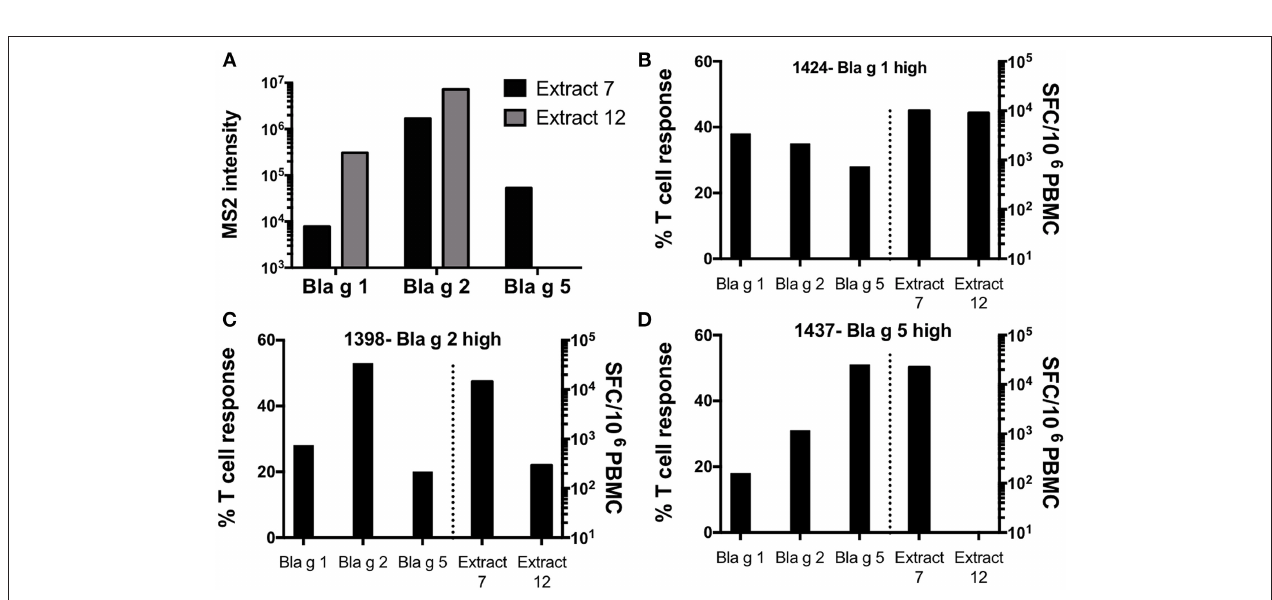
FIGURE 5 | T cell reactivity in three donors in response to two different extracts. Total T cell reactivity (sum of IL-5, IFN γ and IL-10) measured as spot forming cells (SFC) in response to two selected extracts (extract 7 left; extract 12 right) in three individual donors was assessed.